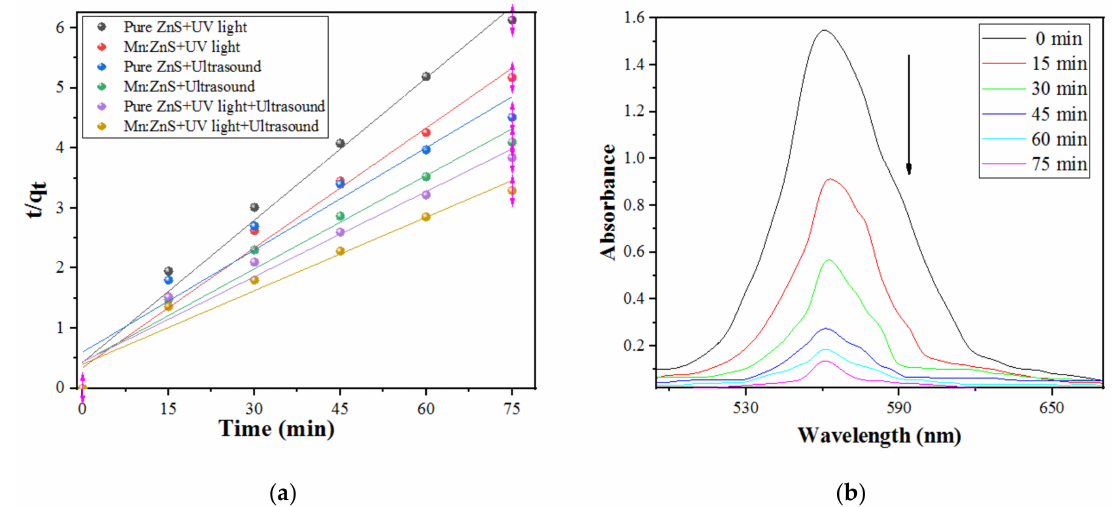
Figure 11. ( a ) Second order kinetic model fitting to the Qds-based degradation of SDB data with pure and Mn 2+ :ZnS Qds and ( b ) absorption spectra of the SDB aqueous solution during sonophotocatalysis in the presence of Mn 2+ :ZnS Qds at optimum conditions (15 mL of SDB 70 ppm, pH 6, 75 min irradiation, 40 mg